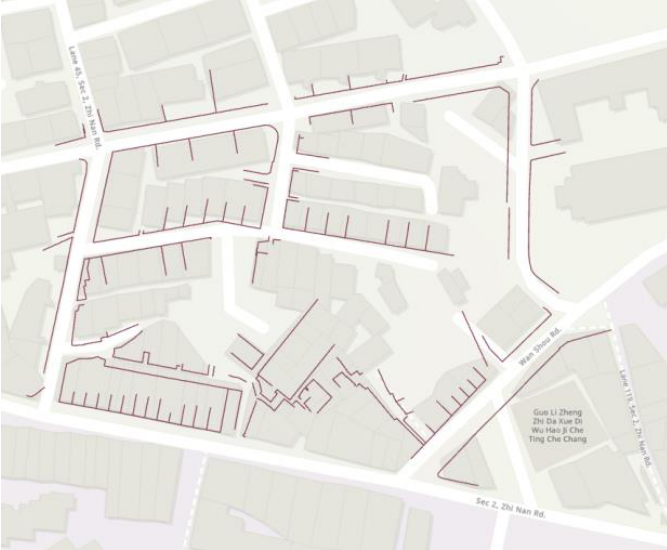
Figure 26. The result of digitized detail lines from the corrected handheld LiDAR point cloud.